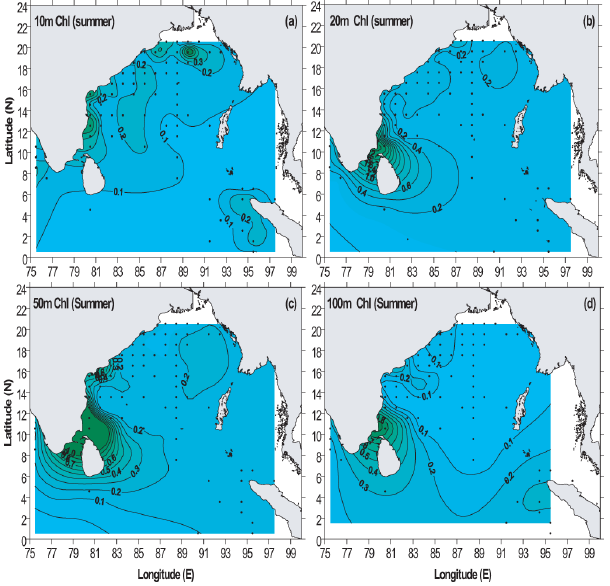
Figure 15. Spatial distribution of chlorophyll a (mgm − 3 ) at (a) 10, (b) 20, (c) 50, and (d) 100m during winter